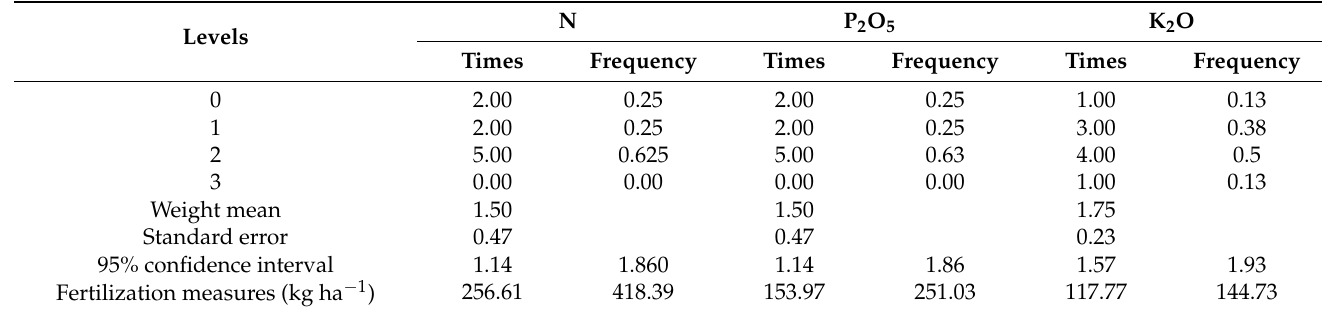
Table 7. The frequency distribution and fertilization measures for biomass per plant > 54